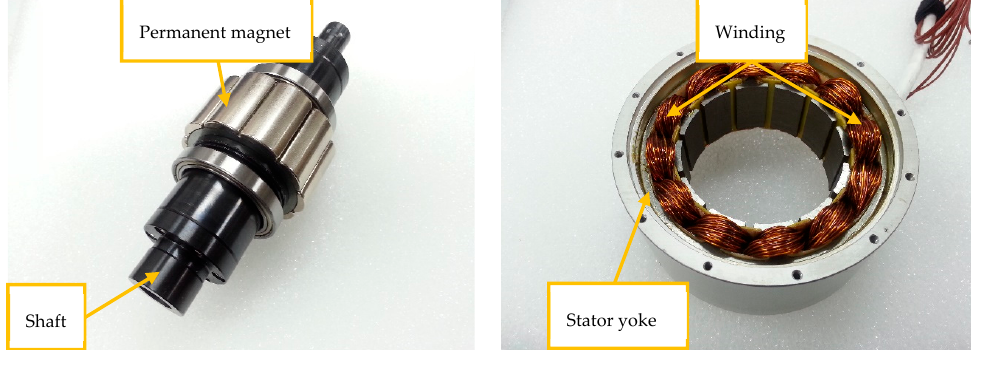
Figure 11. Prototype. Energies 2019 , 12 , 216